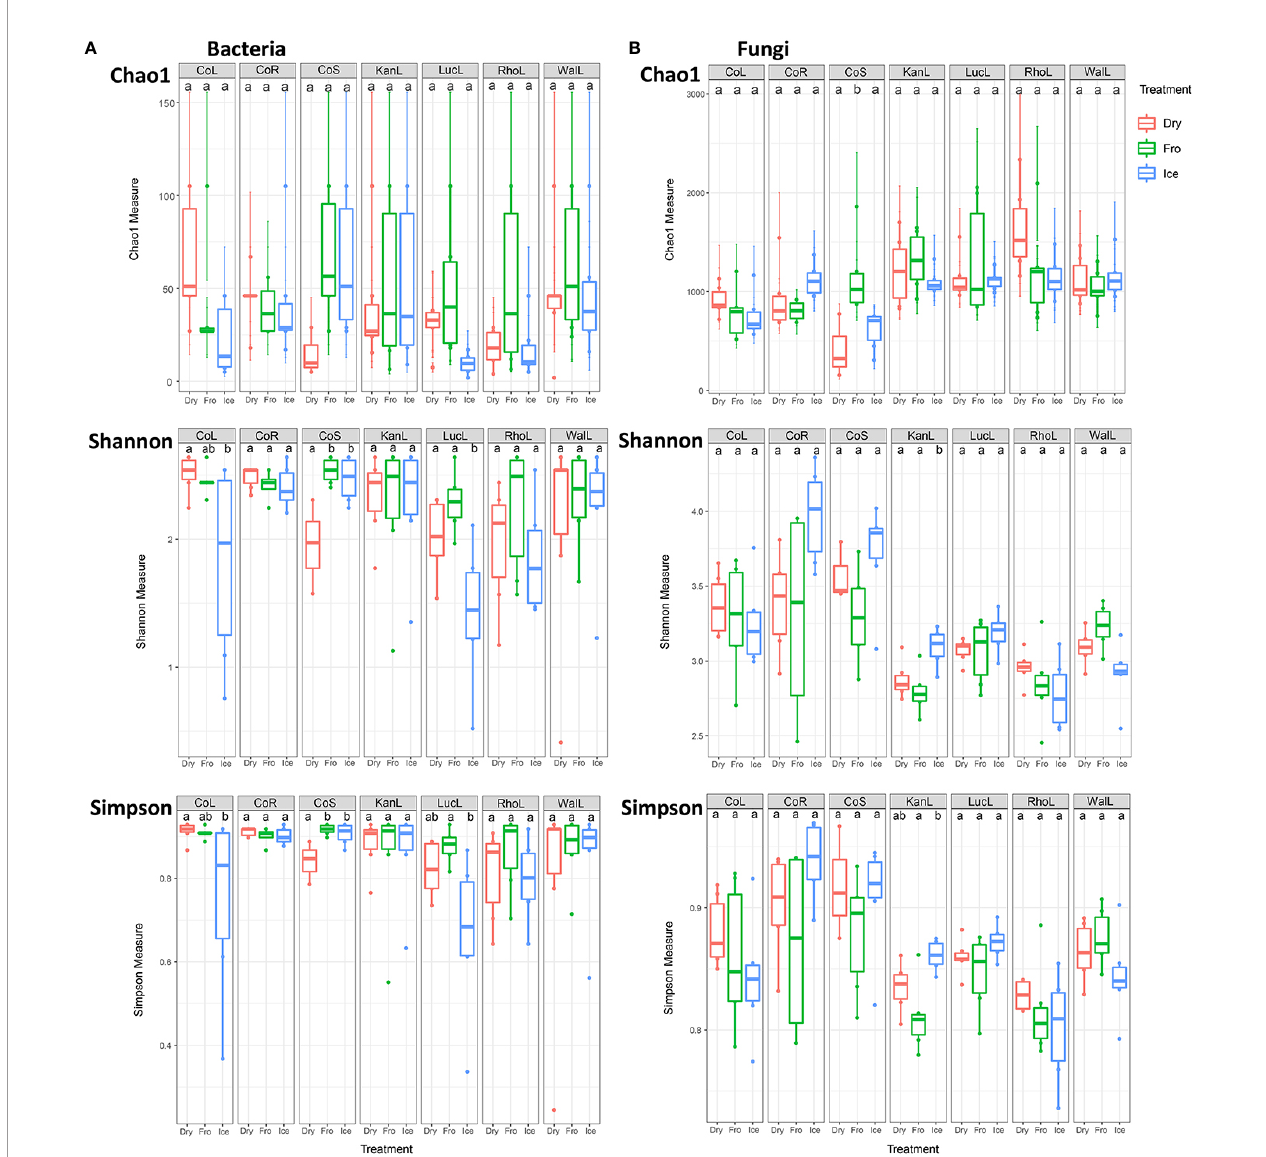
FIGURE 1 | Alpha diversity (Chao1, Shannon and Simpson) indices of bacterial (A) and fungal (B) communities under different preservation methods. Dry = air-dry (red), Fro = snap freezing (green), Ice = ice incubation (blue). CoL = cotton leaf, CoR = cotton root, CoS = cotton stem, KanL = kangaroo leaf, LucL = lucerne leaf, RhoL = rhodes leaf, WalL = wallaby